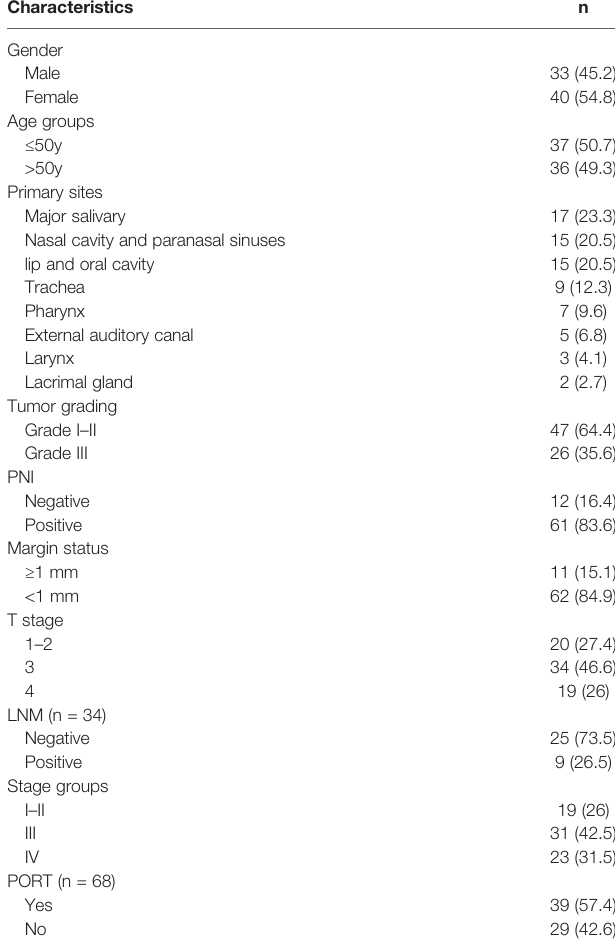
TABLE 2 | Clinicopathological characteristics.